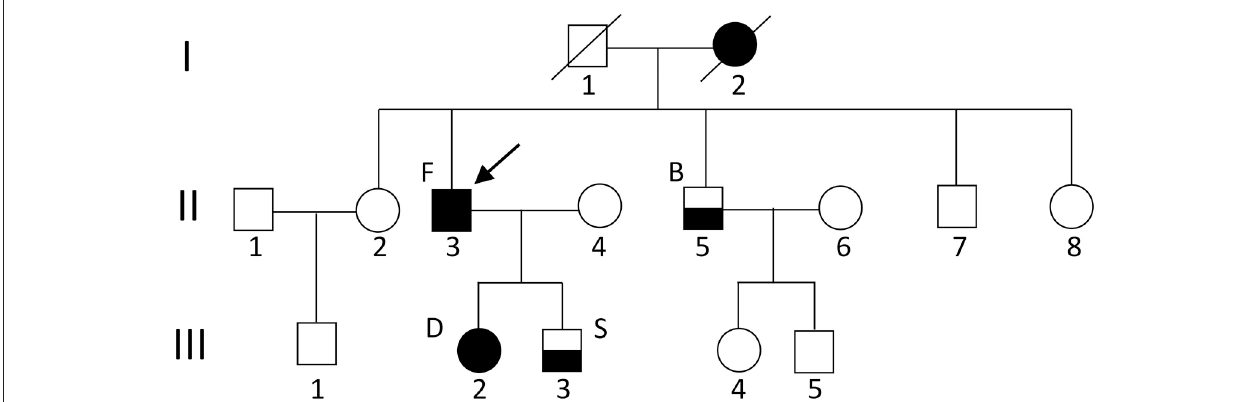
FIGURE 1 | Pedigree of the family. The arrow indicates the proband. Circles indicate females; squares indicate males. The black square/circle indicates a carrier of the FHM1 R583Q mutation with hemiplegic migraine. Lower black half indicates a diagnosis of migraine with aura and no mutation. No DNA was available for genetic testing in other family members.